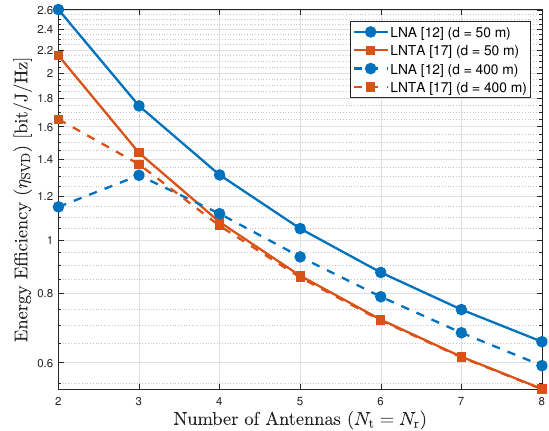
Figure 6. Energy efficiency of the SVD scheme as a function of the number of antennas ( N t = N r ), for d = { 50,400 } m.